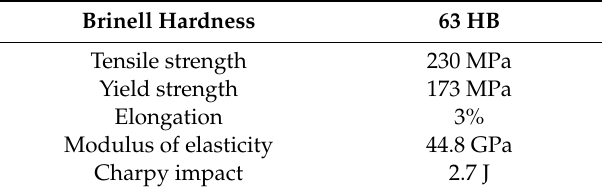
Table 1. Mechanical properties of die casting magnesium alloy UNS